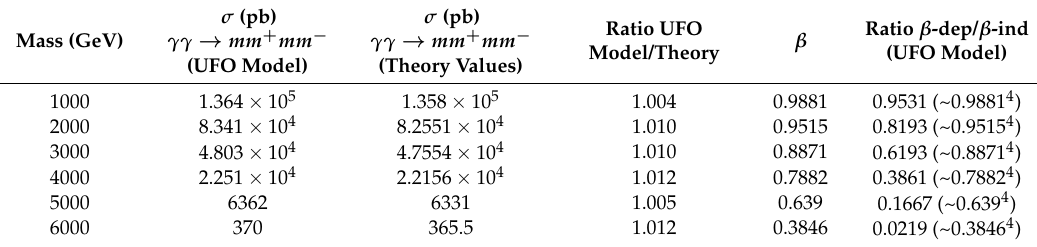
Table 4. The cross-section for the spin 1 / 2 monopole as obtained by the theory and the M AD G RAPH UFO model for the β -dependent coupling constant, when no PDF is used and the center-of-mass energy is 13 TeV. The fourth column shows the ratio of the cross-sections of the UFO model to that of the theoretical prediction. As these ratios are very close to 1, they suggest excellent agreement between the theory and the M AD G RAPH model. Here, the sixth column shows the ratio of cross-sections as obtained by the UFO model for β -dependent coupling to β -independent coupling (shown in Table 3). This ratio varies as β 4 , as expected from the theory